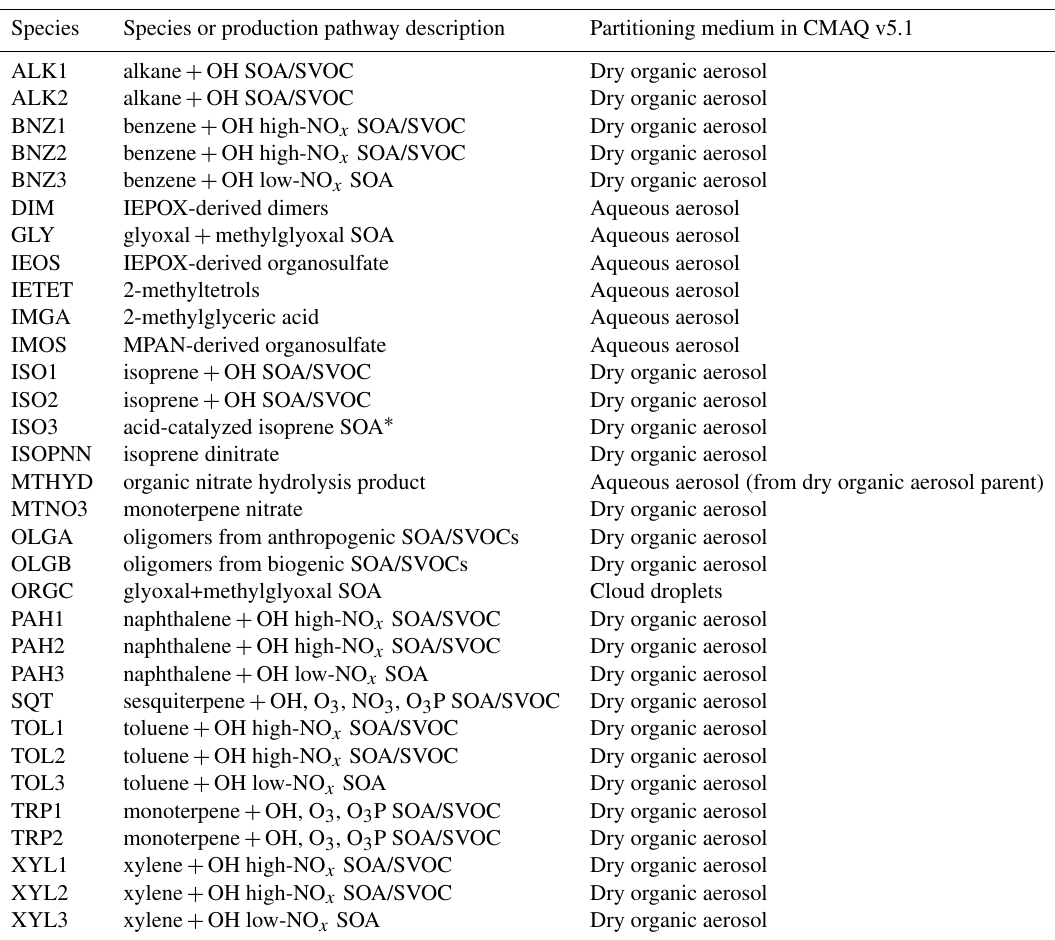
Table 1. SOA and semivolatile organic compound (SVOC) species in CMAQ v5.1-aero6i (Carlton et al., 2010; Pye and Pouliot, 2012; Pye et al., 2013, 2015). CMAQ model species names are generally preceded by the letter A to indicate aerosol. Semivolatile surrogates have a corresponding gas-phase species whose name is preceded by the letters